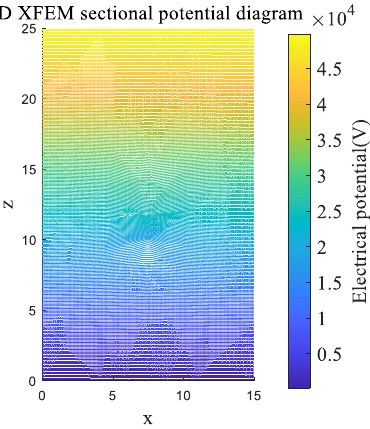
Figure 6. Single bubble potential distribution at x = 7.5 mm.